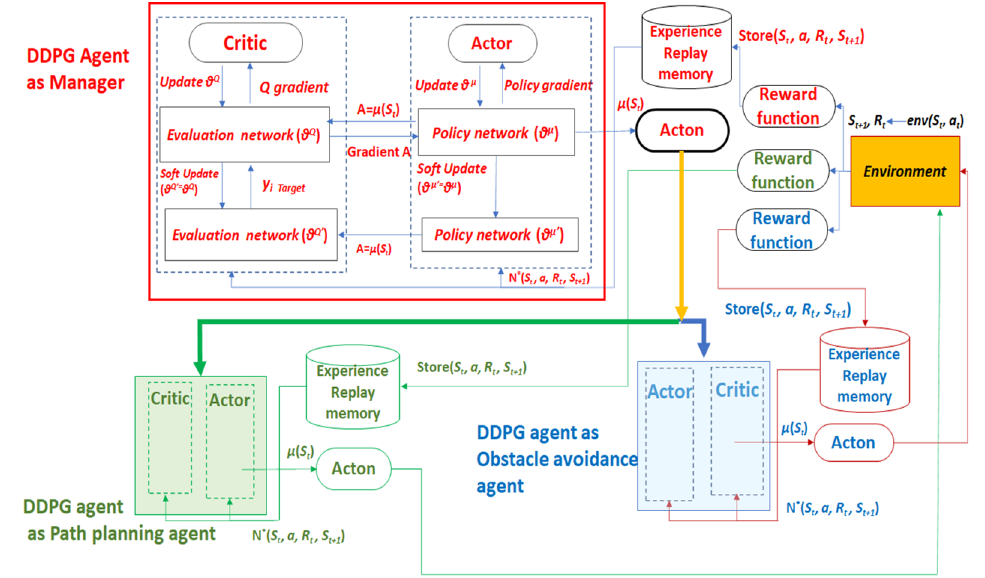
Figure 3. HDDPG architecture with manager–worker strategy.